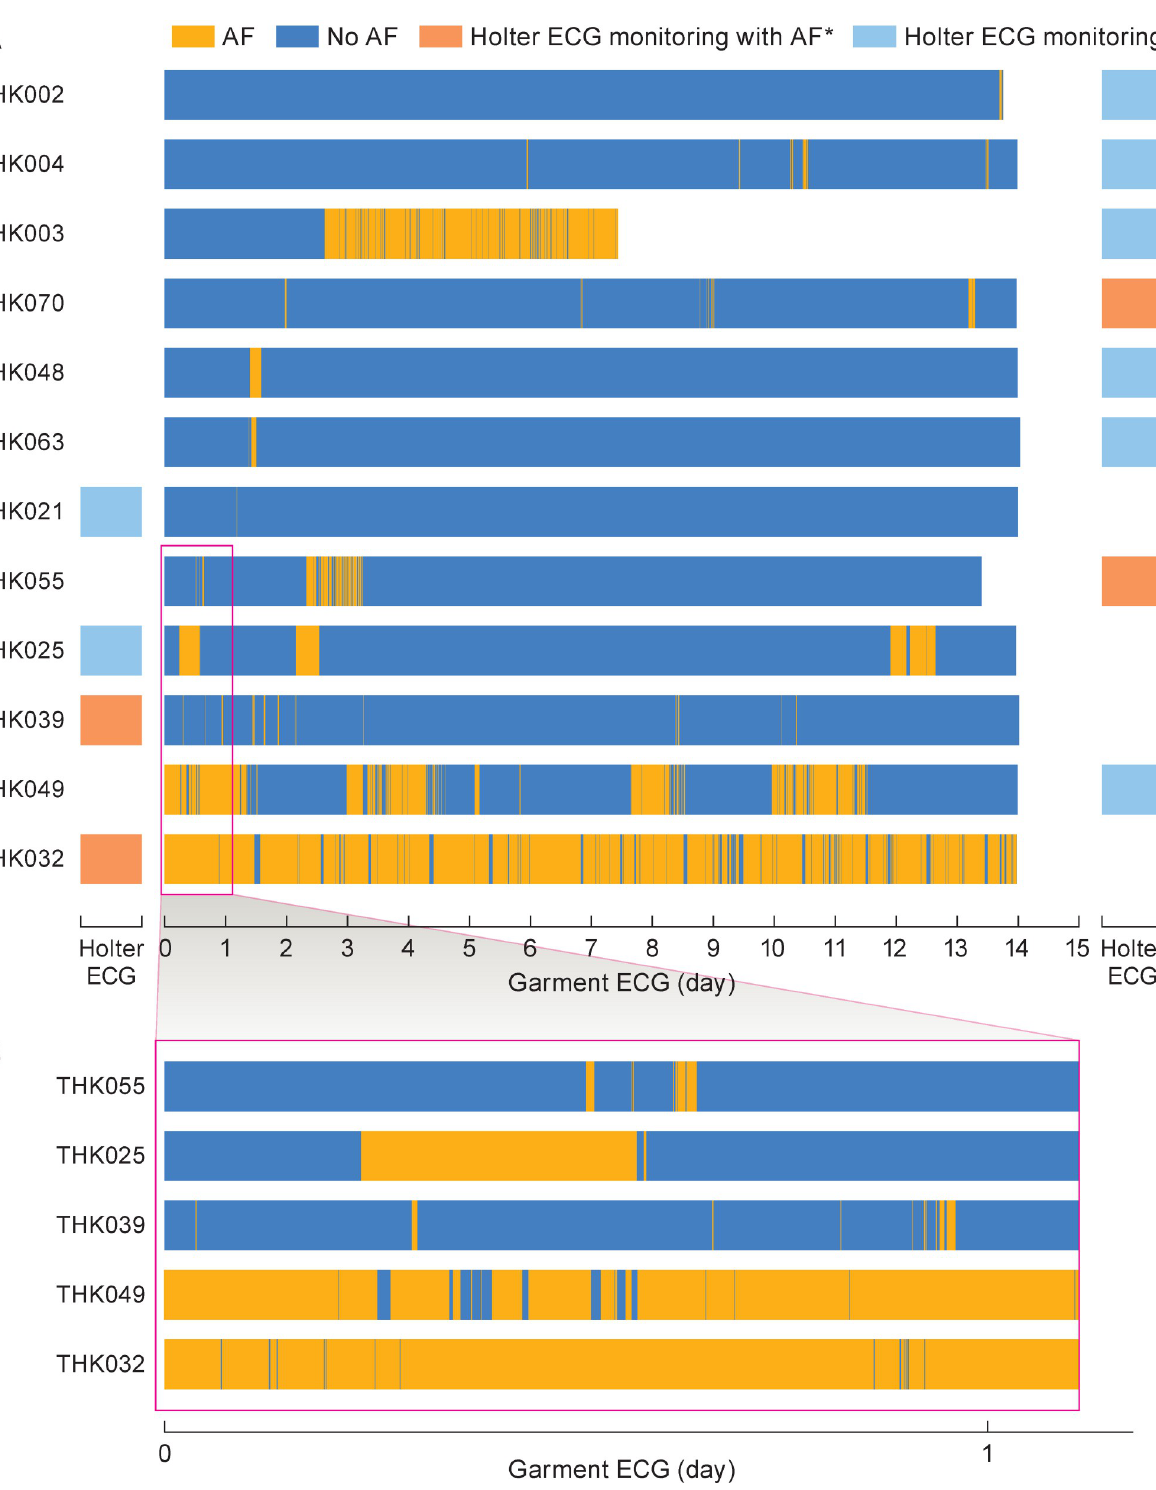
PLOS ONE | https://doi.org/10.1371/journal.pone.0281818 February 24,